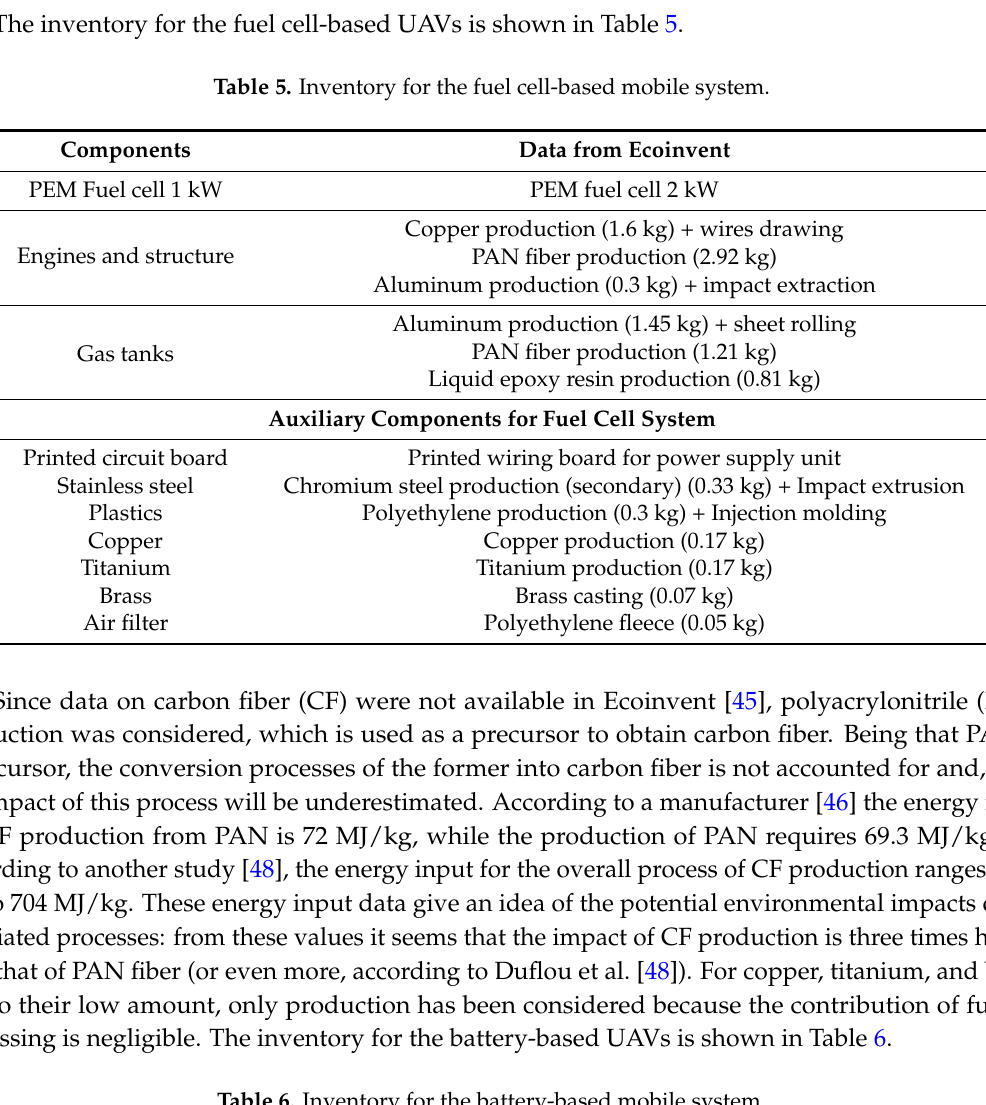
Table 6. Inventory for the battery-based mobile